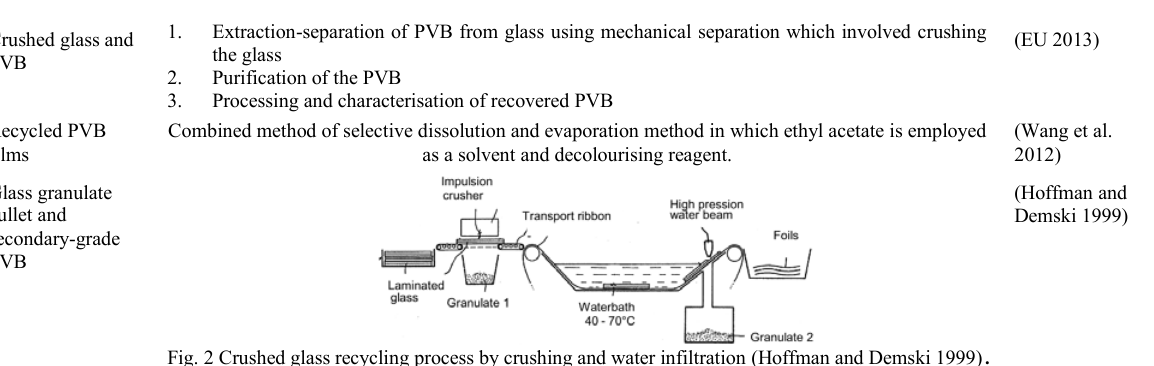
Fig. 2 Crushed glass recycling process by crushing and water infiltration (Hoffman and Demski 1999)